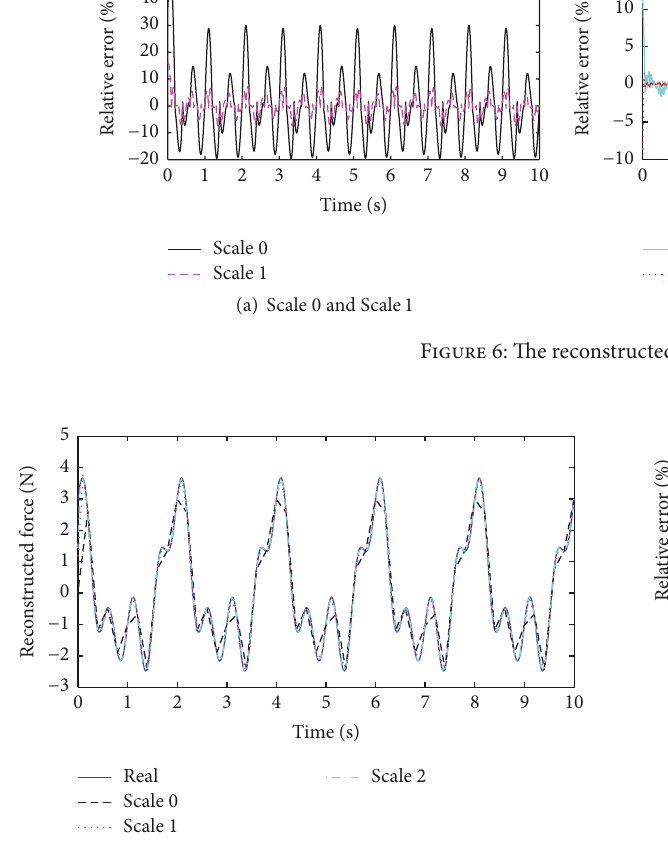
Figure 7: The reconstructed dynamic force in Case B2.